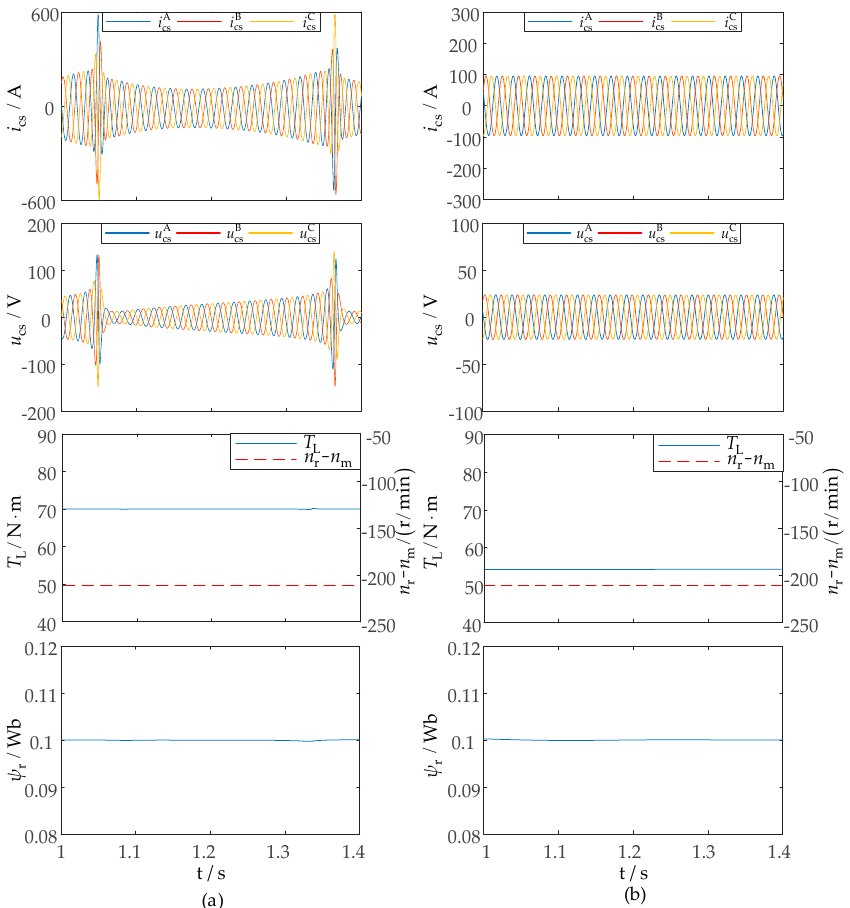
Figure 4. The response waveforms of CRPM-DFM when the non-sinusoidal steady-state solution or sinusoidal steady-state solution exists. ( a ) When the non-sinusoidal steady-state solution exists. ( b ) When the sinusoidal steady-state solution exists. Under a different permanent-magnet flux, rotor flux and speed difference, the range of torque with the sinusoidal steady-state solution is different. When the output torque